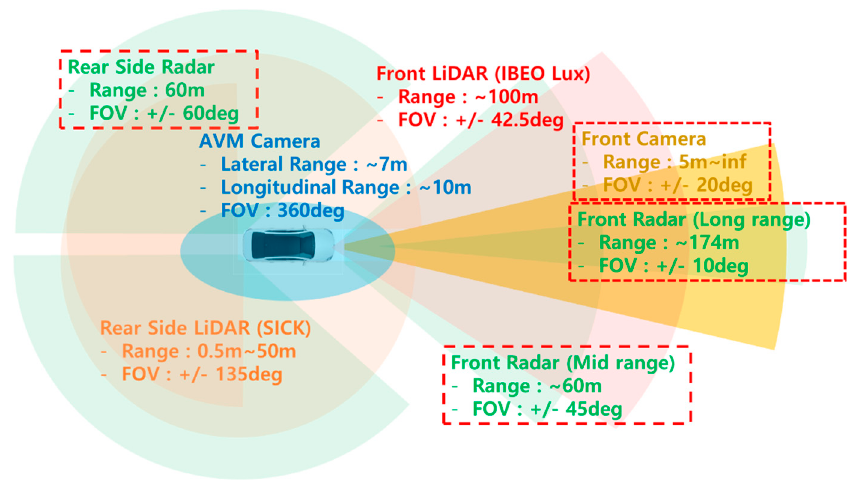
Table 1. Noise specifications of proprioceptive sensors.